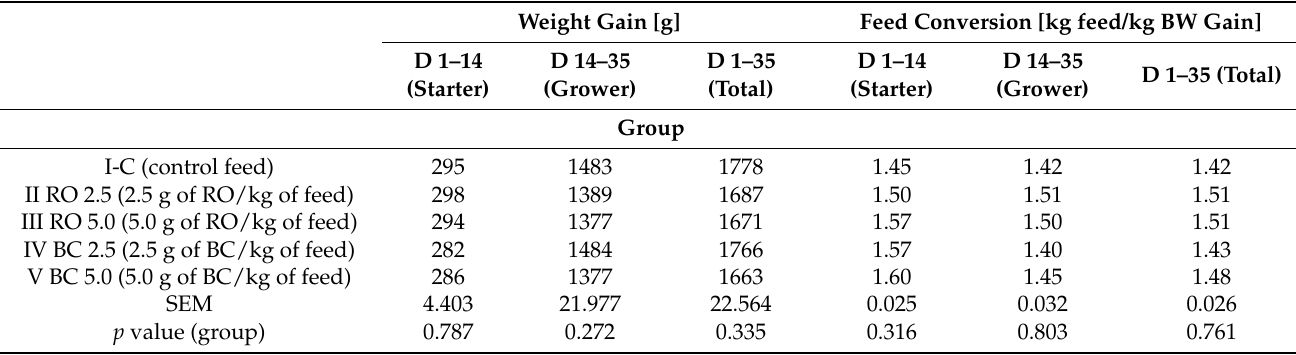
Table 3. Average body weight and feed conversion of broiler